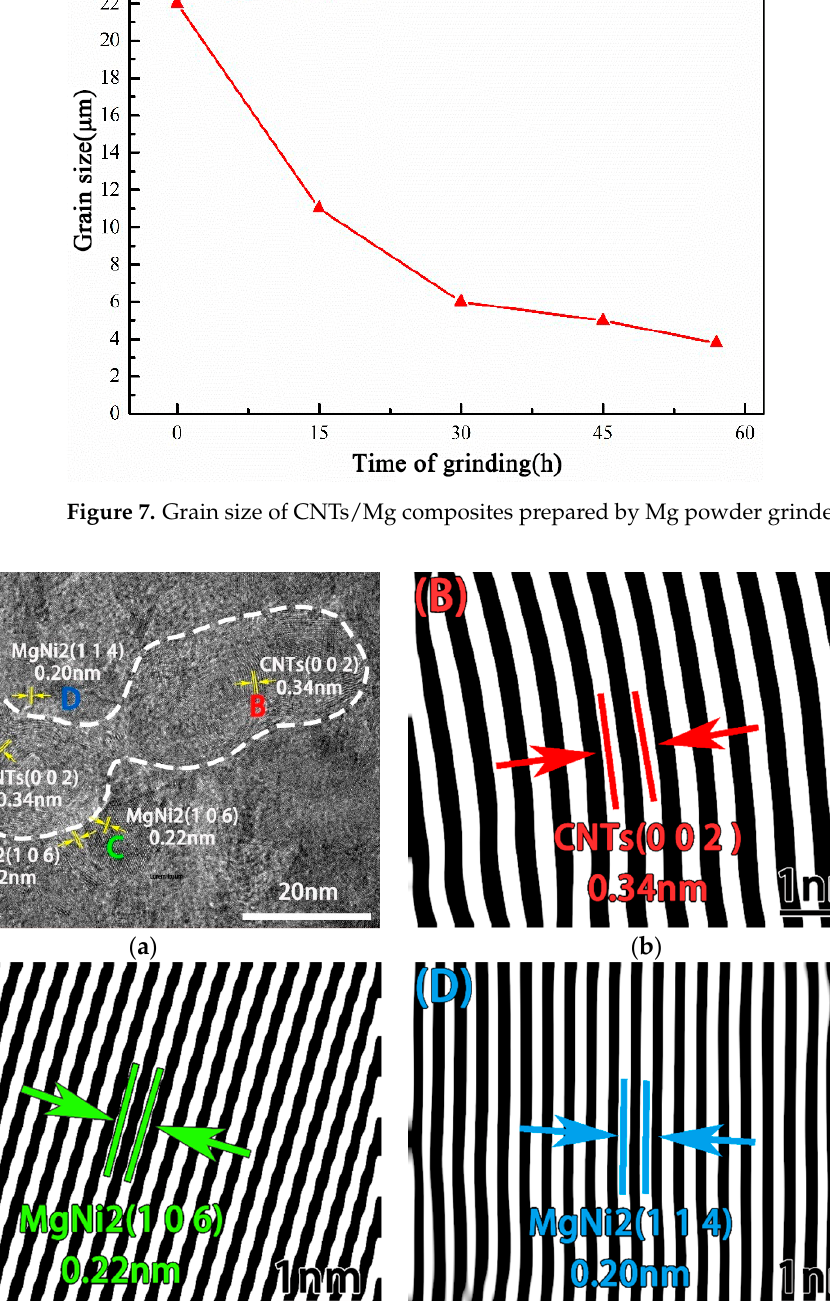
Figure 8. TEM images of CNTs/Mg composites fabricated from Mg powder grinded for 60 h. The layer spacing of regions B, C and D in Figure ( a ) are shown in Figure ( b – d ).